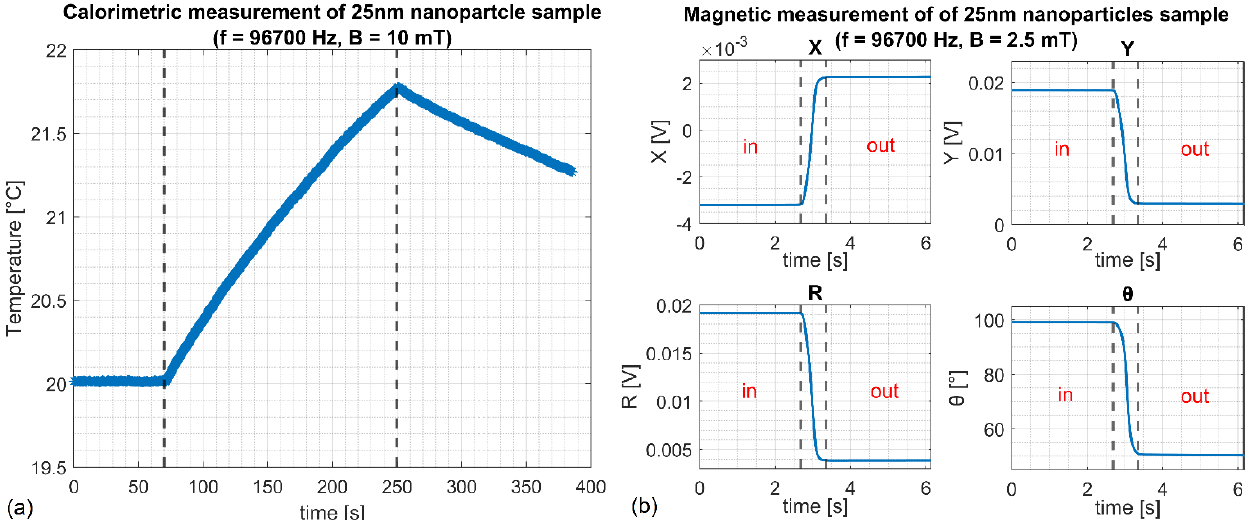
Figure 6. ( a ) Temperature of the nanoparticle solution during the excitation with the AC magnetic field of 10 mT. The dashed lines indicate the 3 − minute heating period. ( b ) Lockin output signals (X, Y, R, T), obtained for the excitation with the AC magnetic field of 2.5 mT, for the sample inside the detection coil, during and after the removal. Calorimetric ( a ) and magnetic ( b ) measurements were conducted at 96,700 Hz for a 2 mL sample of 25 nm nanoparticles.